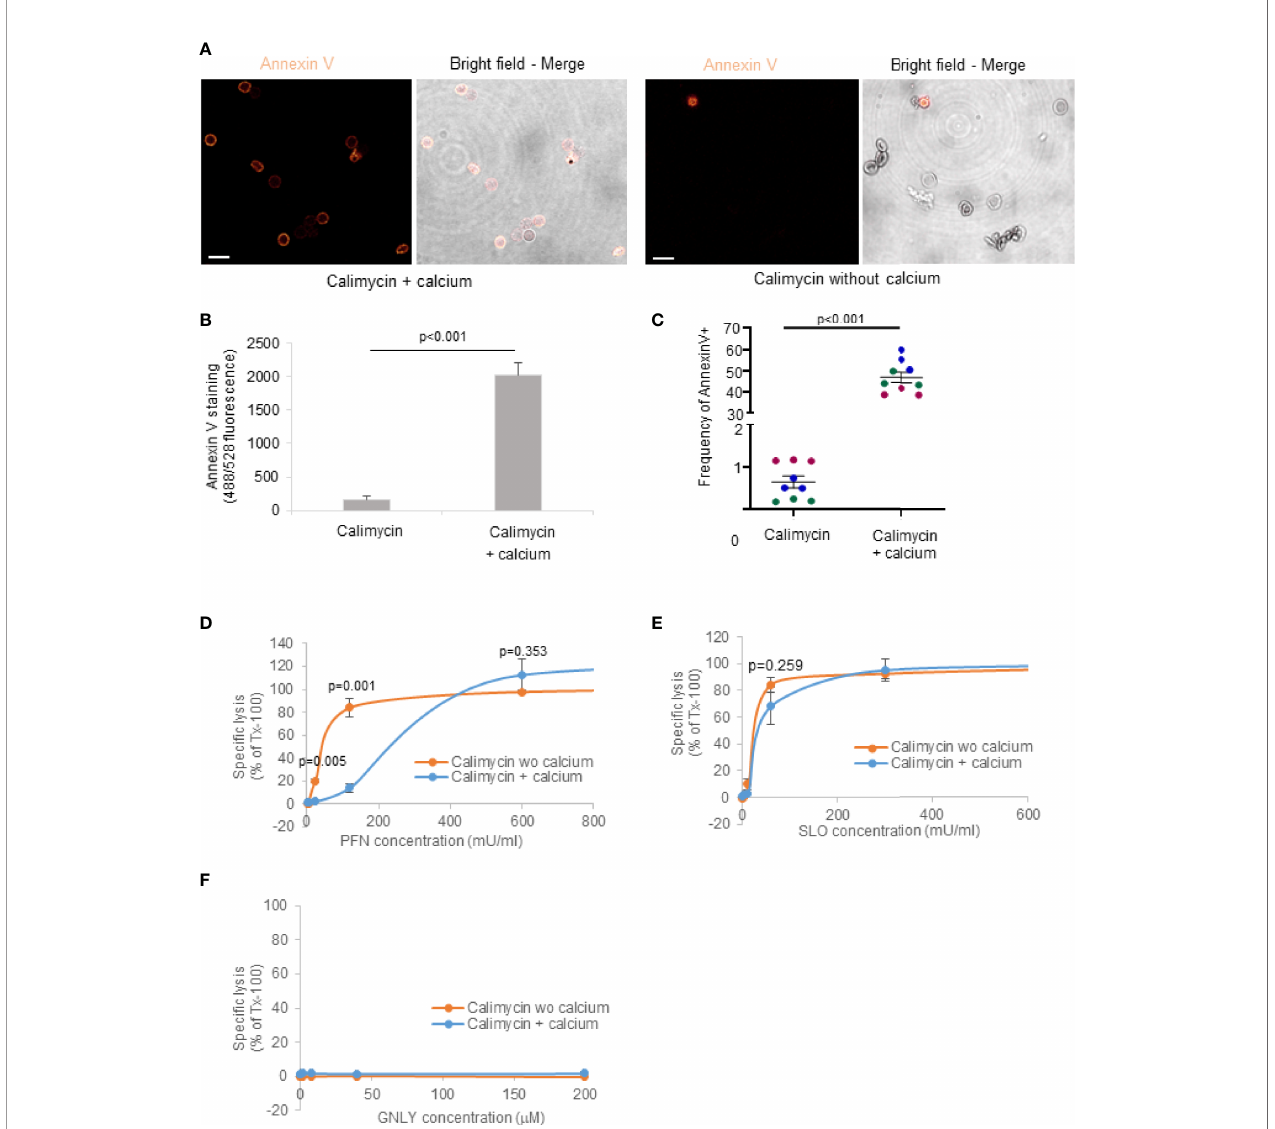
FIGURE 5 | Exposure of phosphatidylserine in the outer RBCs plasma membrane lea fl et mediates resistance to PFN lysis. RBCs were pre-treated with 1 m M calimycin +/- 2 m M calcium for 3 hours at 37°C, then washed with PBS and stained with Annexin V-FITC for 1 hour on ice for confocal microscopy (A) or treated with indicated concentrations of PFN (D) , SLO (E) or GNLY (F) for 15 minutes at 37°C before hemoglobin release assay. Averages +/- SEM of the fl uorescence of annexin V stained cells assessed by plate reader is demonstrated in (B) . Averages and values of single experiments represented by dots in different colors indicating the frequency of annexin positive cells assessed by fl ow cytometry are shown in (C) . In (A) , scale bars are 10 m m. P values of signi fi cant differences were calculated with unpaired t-test. wo,